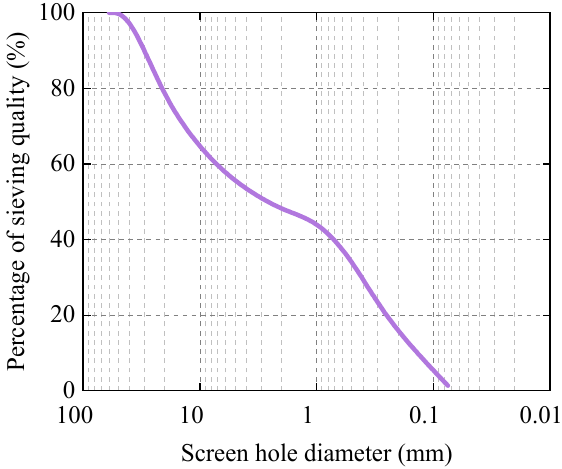
Figure 1. Particle grading curve of filling soil.